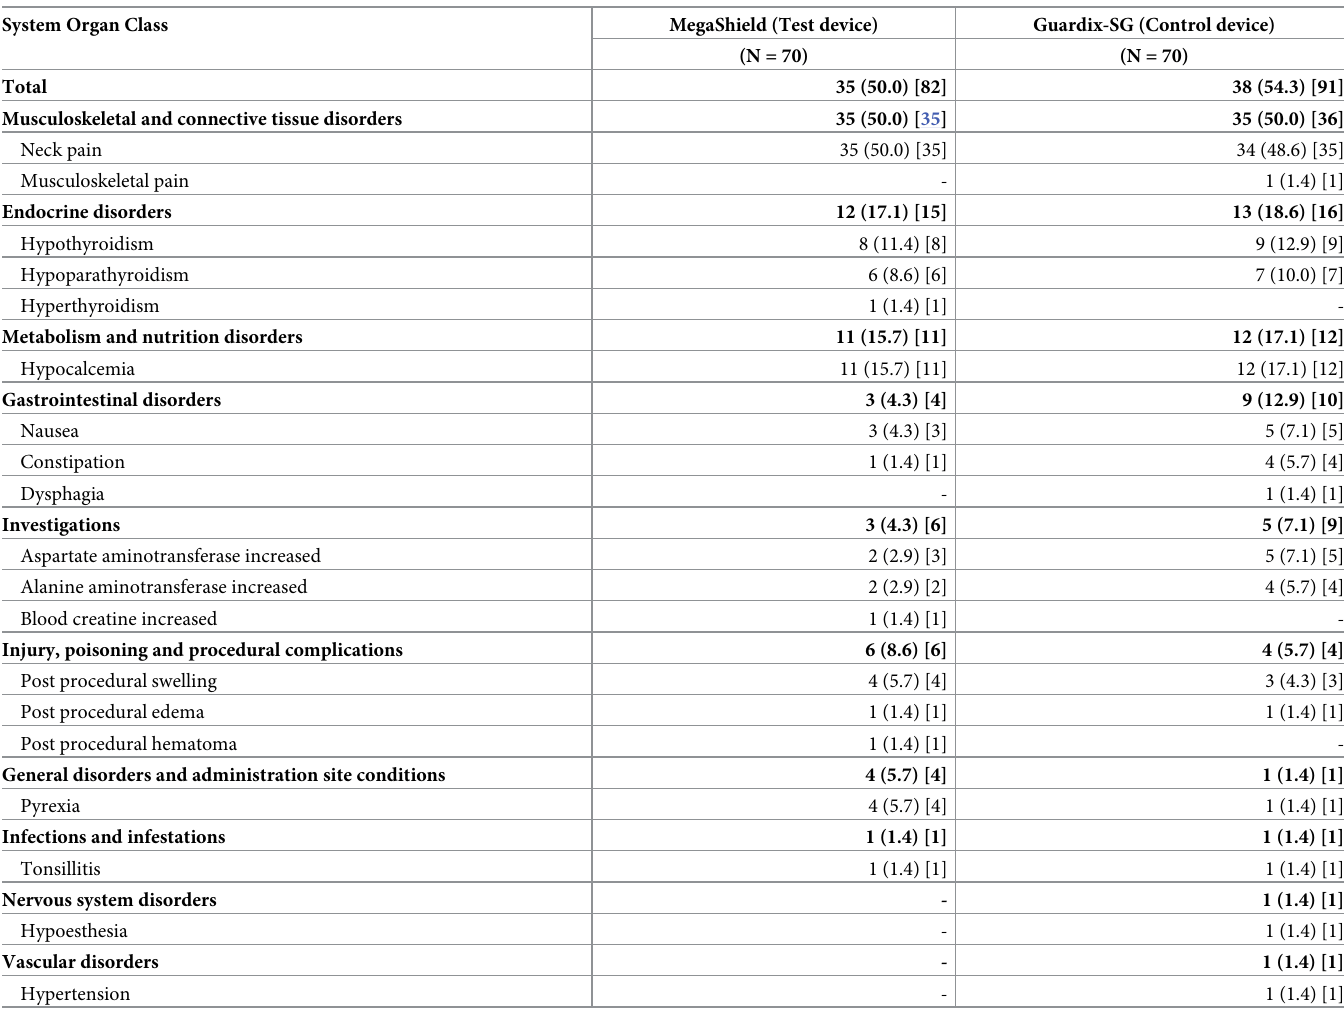
Table 7. Summary of adverse events by organ system classification (ITT